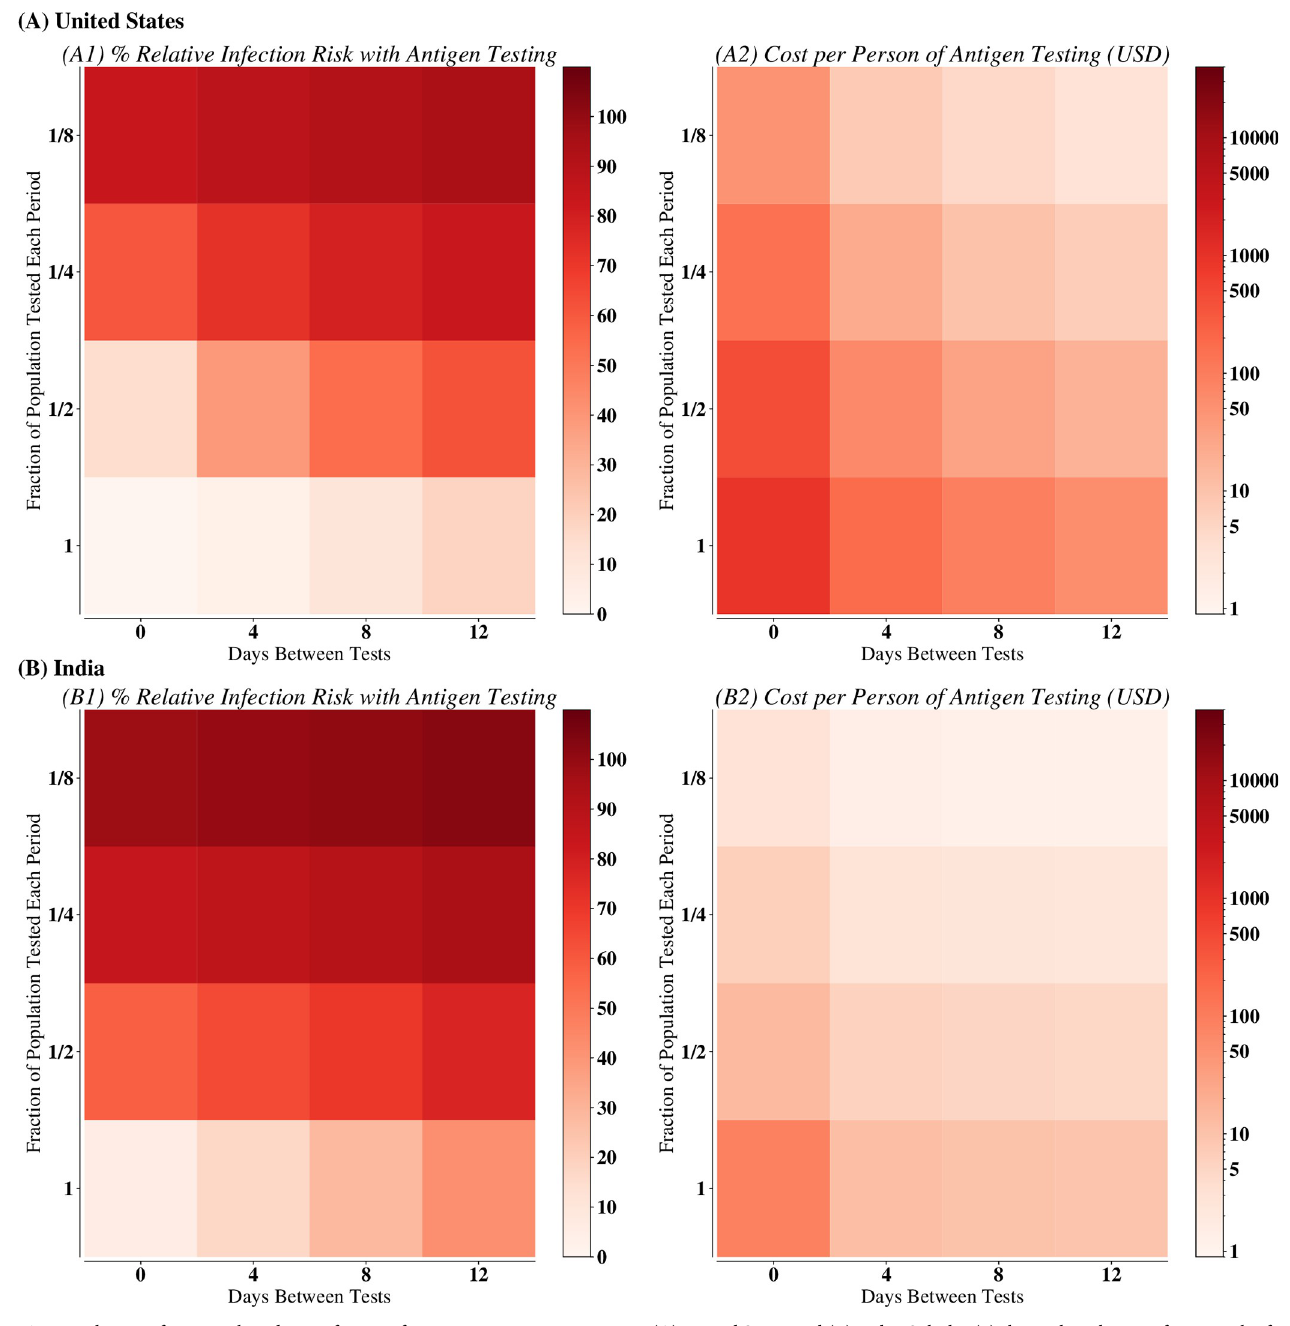
Fig 2. Relative infection risk and cost of testing for various antigen scenarios in (A) United States and (B) India. Subplot (1) shows the relative infection risk of antigen tests being used at the given frequency and coverage, compared with the scenario with no mitigation. Subplot (2) provides the cost of that testing scenario assuming that all susceptible individuals are tested at the given frequency and